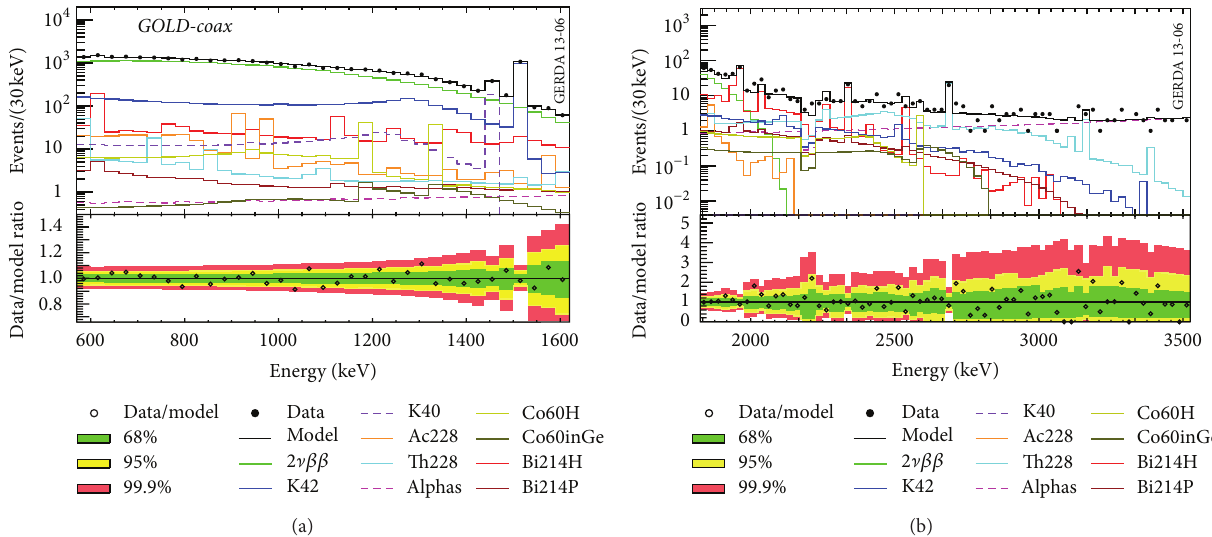
Figure 7: (a) shows the background decomposition (black histogram) and the observed spectrum (black dots) using the best fit minimum model for the 𝐺𝑂𝐿𝐷 - 𝑐𝑜𝑎𝑥 data set in the energy range from 570 keV to 1650keV. The lower panel shows the data over model ratio (empty points) and the smallest intervals containing 68% (green), 95% (yellow), and 99.9% (red) probability for the model expectation. (b) shows the same for the energy range from 1650keV to 3750 keV. From [28].